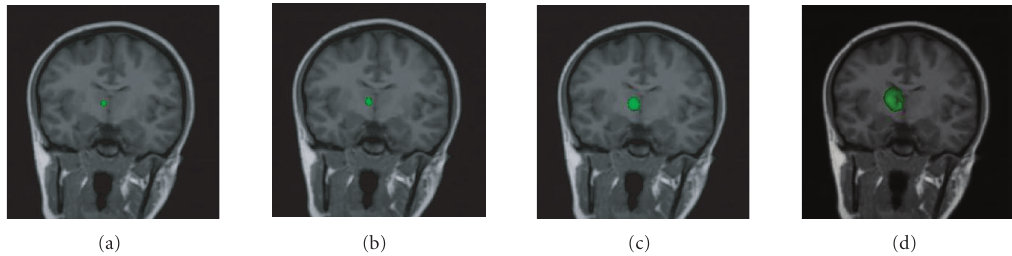
Figure 3: The model evolution process of the 3D thalamus segmentation superimposed with original image. (a) Initial seed; (b)-(c) two intermediate stages; and (d) final extracted